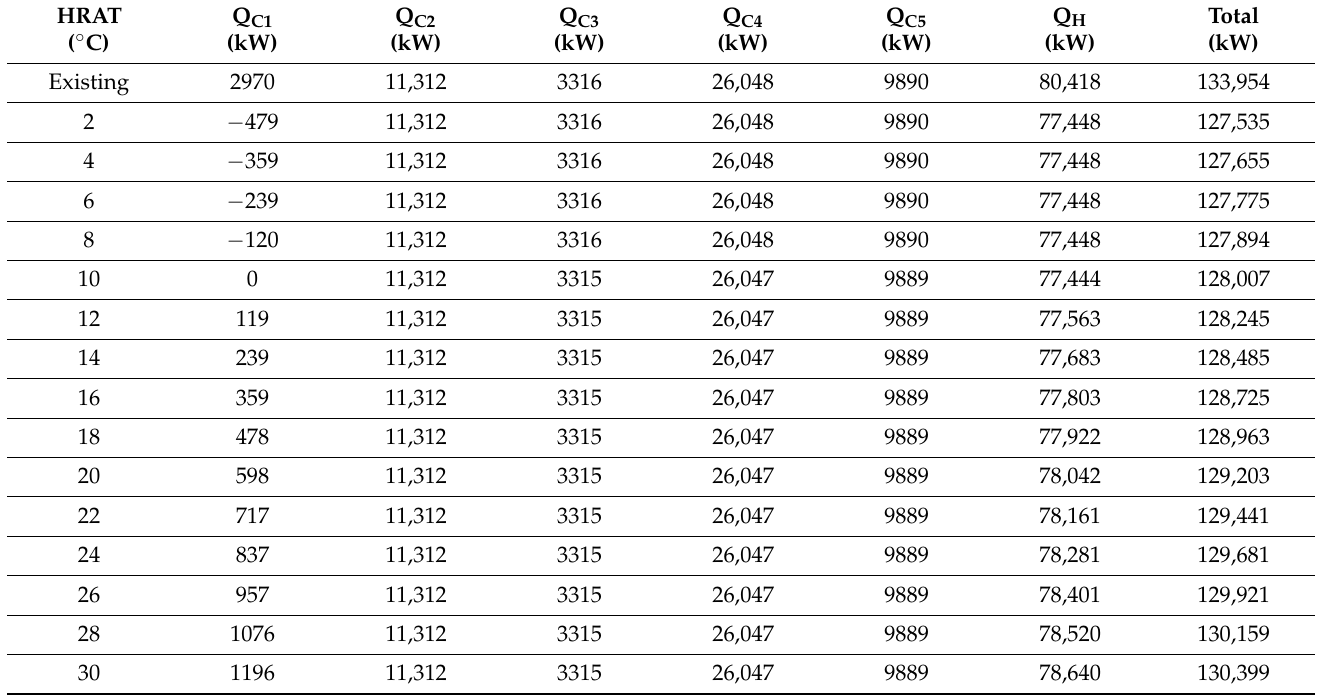
Table A9. External energy consumption at different HRAT values for option